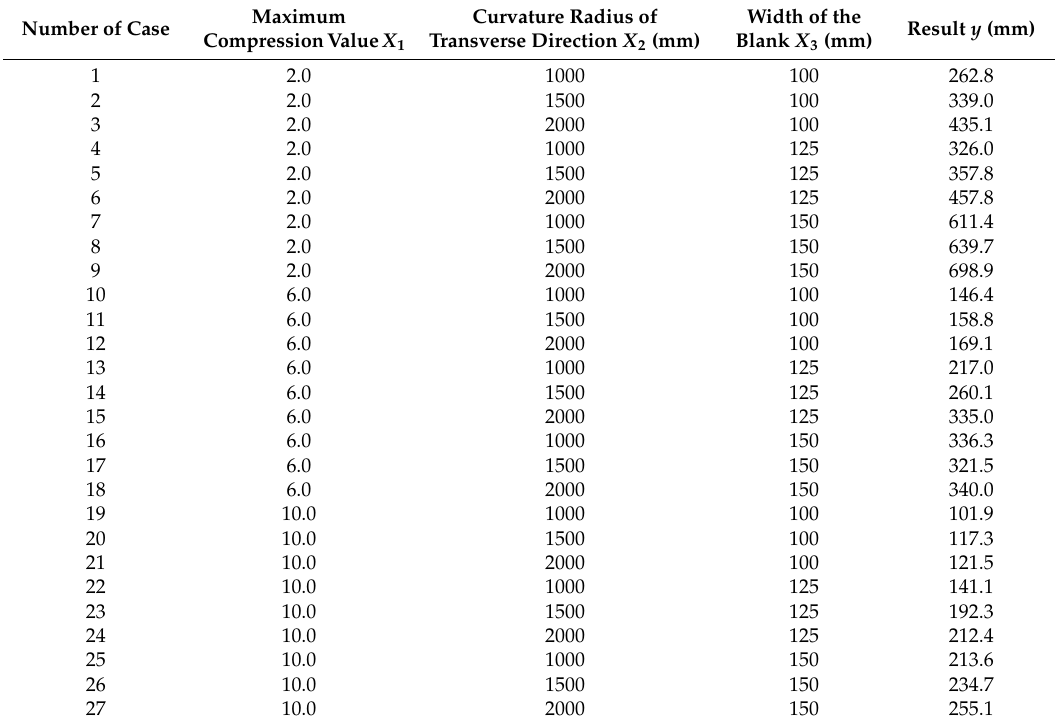
Table 3. Statistical table for convex shape.